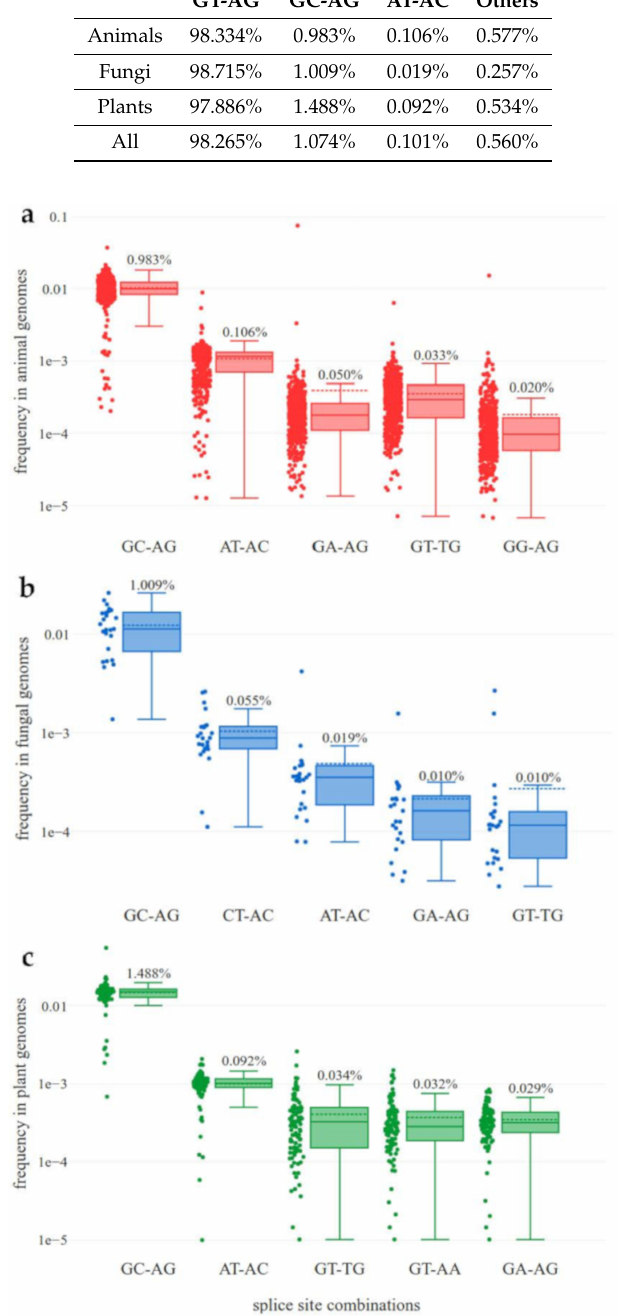
Figure 1. Frequencies of non-canonical splice site combinations in animals, fungi, and plants. The frequency of non-canonical splice site combinations across the 489 animal (red, a ), 130 fungal (blue, b ), and 121 plant (green, c ) genome sequences is shown. Normalization of the absolute number of each splice site combination was performed per species based on the total number of annotated splice site combinations in representative transcripts. The frequency of the respective splice site combination of each species is shown on the left-hand side and the percentage of the respective splice site combination is shown on top of each box plot. The dashed line represents the mean frequency of the respective splice site combination over all investigated species. The box plots are ordered (from left to right) according to the mean